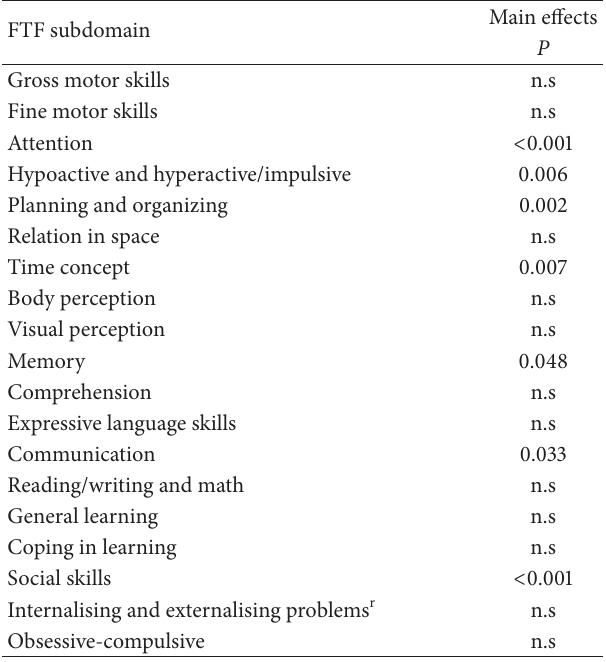
Table 4: Main effects for comparisons amongst ADHD and ASD